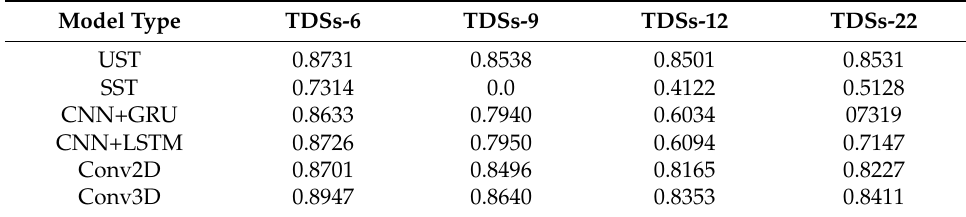
Table 6. F-1 scores of six backbones on four task-sets.